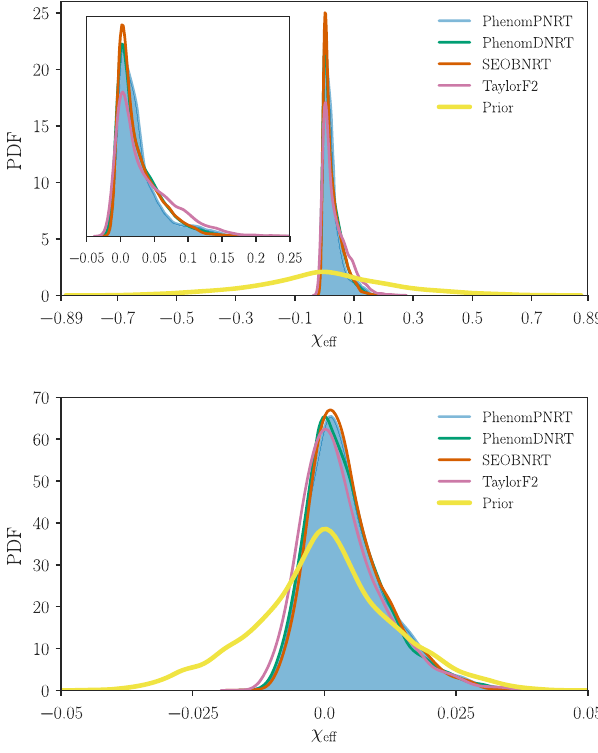
FIG. 6. Posterior PDF for the effective spin parameter χ using the high-spin prior (top panel) and low-spin prior (bottom panel). The four waveform models used are TaylorF2, PhenomDNRT, PhenomPNRT, and